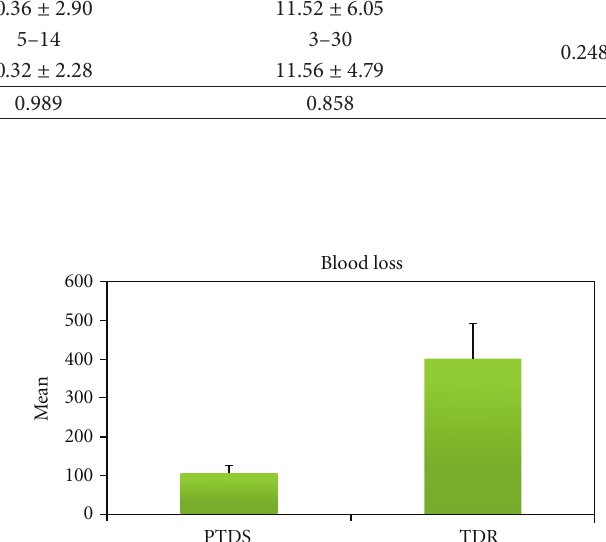
F3:Lordosisofthelumbarspine(L1-S1)wasmeasuredviathe angle between the lines drawn from the lower endplate of L1 and the upper endplate of S1 (LL). Additionally segmental lordosis ( operation level was measured via the angle between the lines drawn from the upper and lower endplates of the vertebrae that form the operation segments.